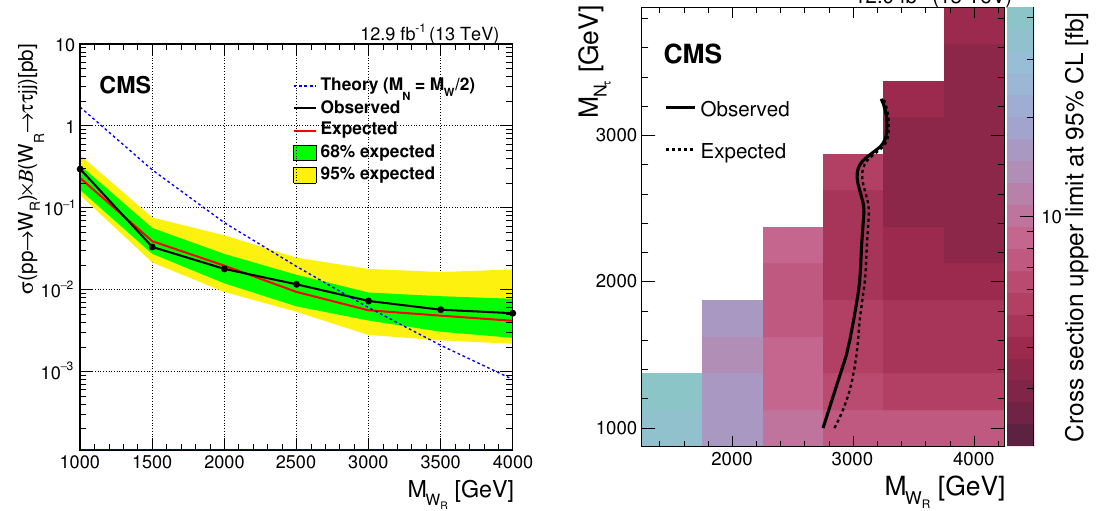
Figure 3 . Observed and expected limits at 95% CL on the product of cross section and branching fraction, obtained from the combination of the e (cid:28) h and (cid:22)(cid:28) h channels in the heavy right-handed neutrino analysis (left) and the observed and expected limits at 95% CL on the production cross section as a function of M W and M N (right). The green and yellow bands represent the one R R and two standard deviation uncertainties in the expected limits. The dashed dark blue curve represents the theoretical prediction for the product of the W R boson production cross section and the branching fraction for decay to a (cid:28) lepton and RH neutrino, assuming the mass of the RH neutrino to be half the mass of the W R boson